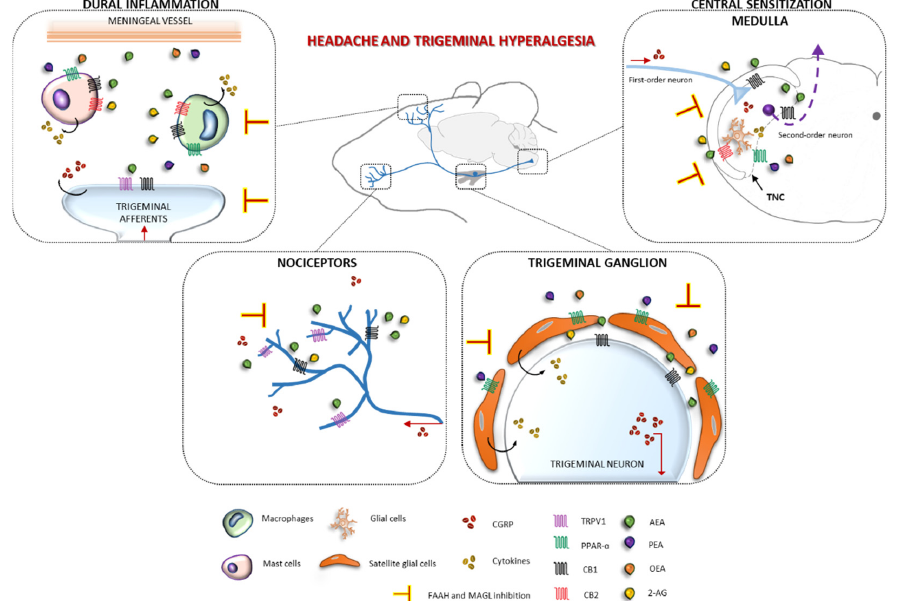
Figure 8. Trigeminal afferents, arising in the trigeminal ganglion, convey sensory information from the intracranial and extracranial sites to the trigeminal nucleus caudalis (TNC), causing trigeminal hyperalgesia. Inflammation induced by NTG in the dura and trigeminal ganglion stimulates the local release of endocannabinoids and congeners from primary sensory afferents and non-neural cells, including macrophages and mast cells. Endocannabinoids and congeners (PEA, OEA), released from membrane’s lipids, may be initiated by calcium entry in nociceptors and macrophages. Successively, lipids may activate CB1 and/or CB2 or PPAR- α , modulating membrane excitability and calcium signals in primary afferent terminals, inhibiting macrophage activation and mast-cell degranulation and thus inflammation. Alternatively, AEA might induce desensitization of the transient receptor potential vanilloid 1 channel (TRPV1), probably via inhibition of the release of nitric oxide or of neuropeptides from primary afferents at the spinal level.